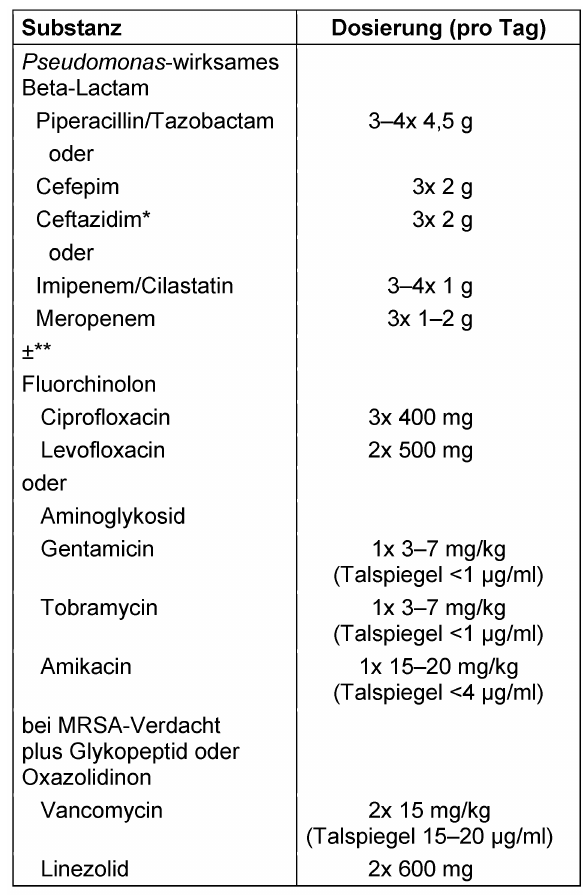
Tabelle 11: Empfehlung für die kalkulierte